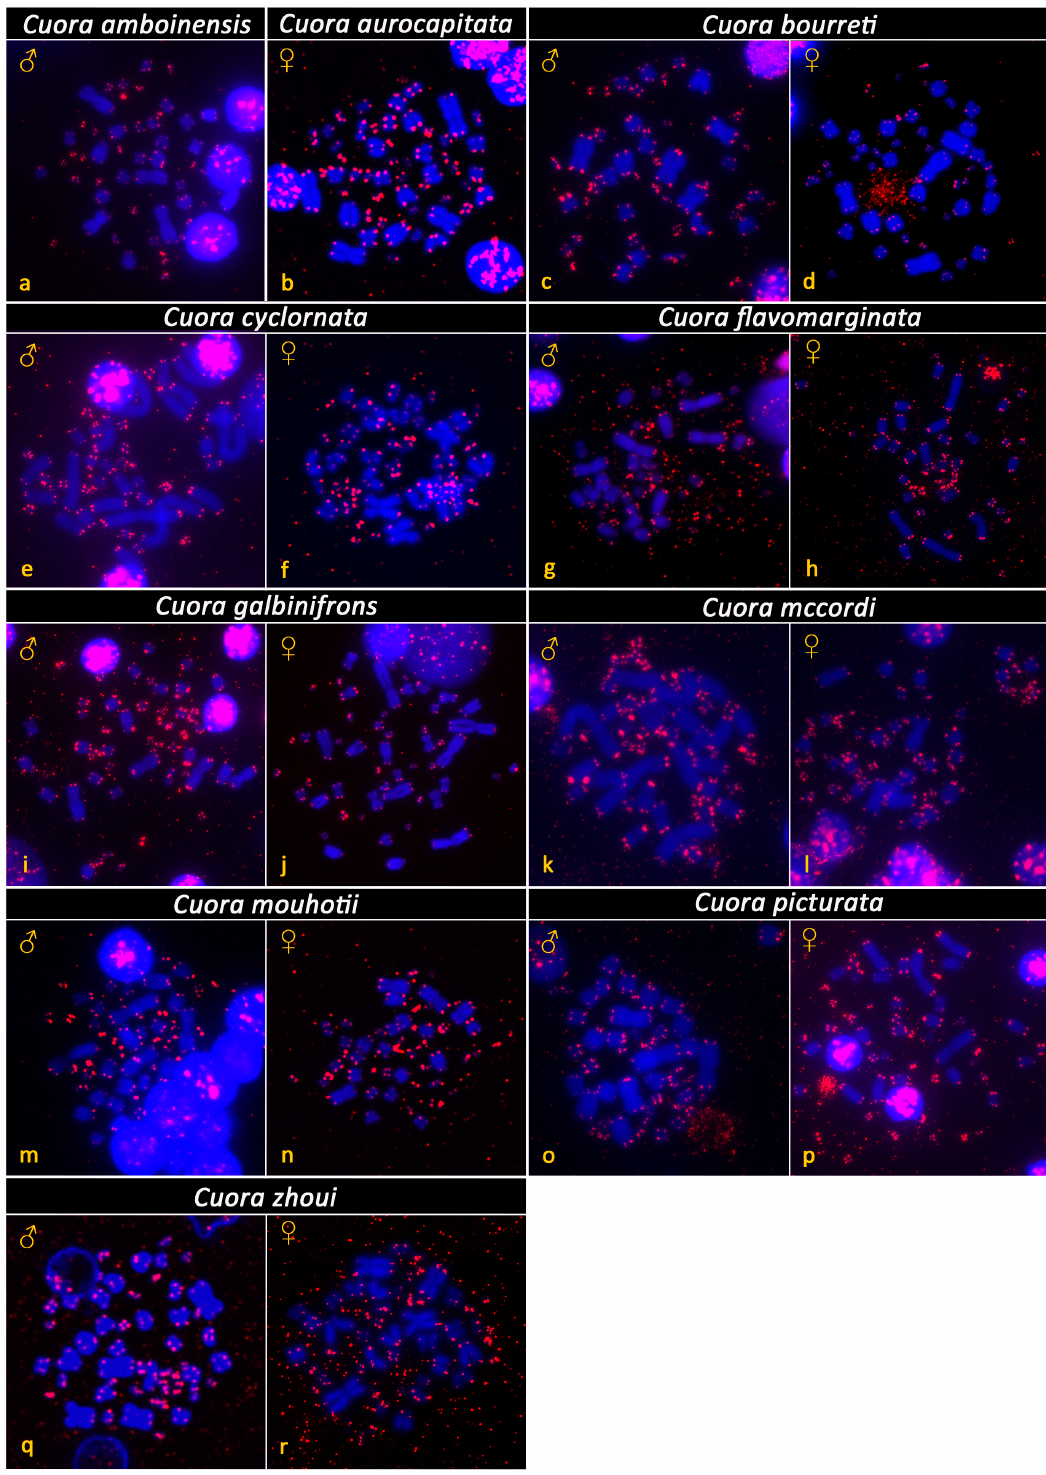
Figure 4. Distribution of telomeric repeats (red color) on DAPI-stained metaphases (blue color) from Cuora amboinensis ( a ), Cuora aurocapitata ( b ), Cuora bourreti ( c , d ), Cuora cyclornata ( e , f ), Cuora flavomarginata ( g , h ), Cuora galbinifrons ( i , j ), Cuora mccordi ( k , l ), Cuora mouhotii ( m , n ), Cuora picturata ( o , p ), and Cuora zhoui ( q , r ). Telomeric repeats have the expected topology at the edges of the chromosomes in all examined species. Interstitial telomeric repeats were not detected. In a wider phylogenetic context, the diploid chromosome number of 2n = 52 seems to be ancestral not only for the genus Cuora , but also for the clade Testudinoidea, consist- ing of the families Geoemydidae (Figure 5), Emydidae, Platysternidae, and Testudinidae,